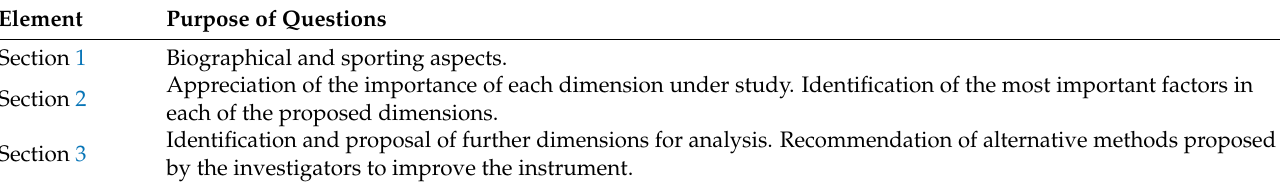
Table 2. Questionnaire structure.